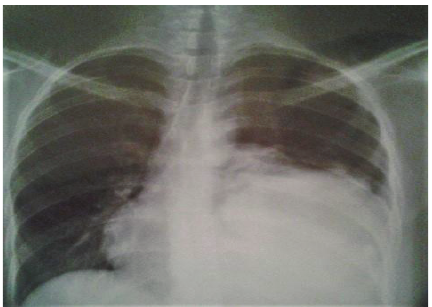
Figure 1: Chest X-ray shows a large opacity of the entire left hemi- thorax.